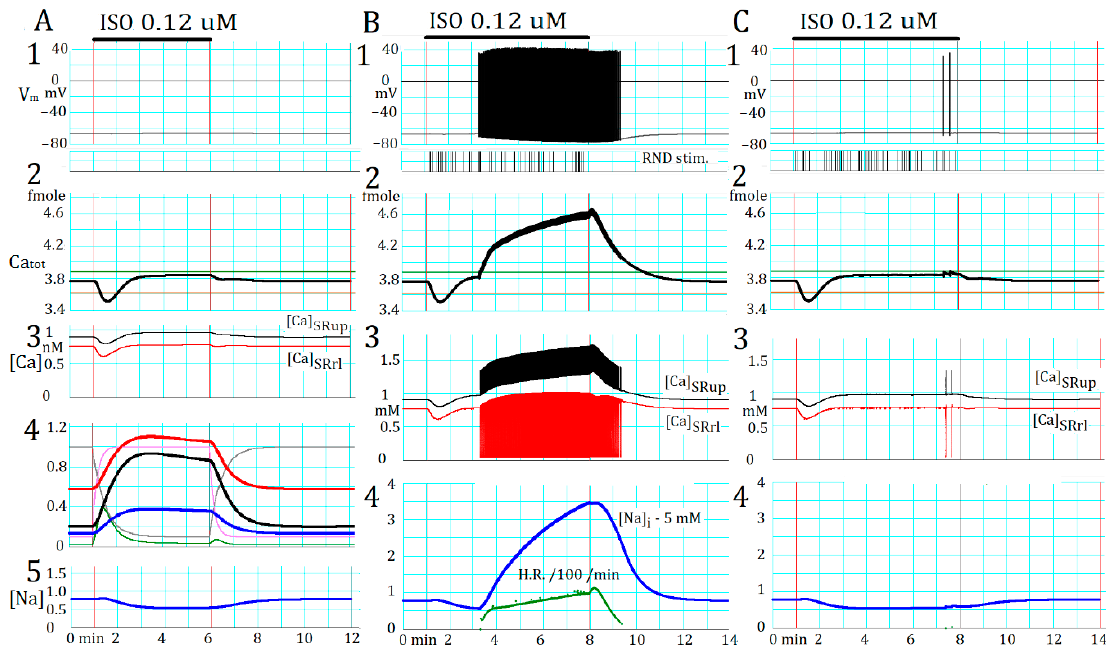
Figure 5. Initiation of a train of AP TD by the α 1-adrenergic receptor (AR) stimulation. The application of 0.12 µ M ISO and 0.15 µ M IP 3 is indicated by the horizontal bars at the top of each column and the pair of vertical lines. ( A ) AP TD was not induced. ( B , C ) The random triggering signals applied are shown in the lower part of B1 and C1 (random (RND) stim) to induce AP TD . The responses of V m (1), Ca tot (2), [Ca 2 + ] SRup and [Ca 2 + ] SRrl (3), and [Na + ] i (5 in A and 4 in B , C ) are shown in each column. The time courses of afI CaL ( × 0.5, red), af SERCA (black), af Na / K (blue), and pO InsP3R ( × 100, green) shown in Figure 5(A4) are applicable to responses in ( B , C ). The rate of AP TD discharge ( / min / 100) appears only in Figure 5(B4). The horizontal green and brown lines are the threshold Ca tot measured in the absence and presence of AR stimulation, respectively.